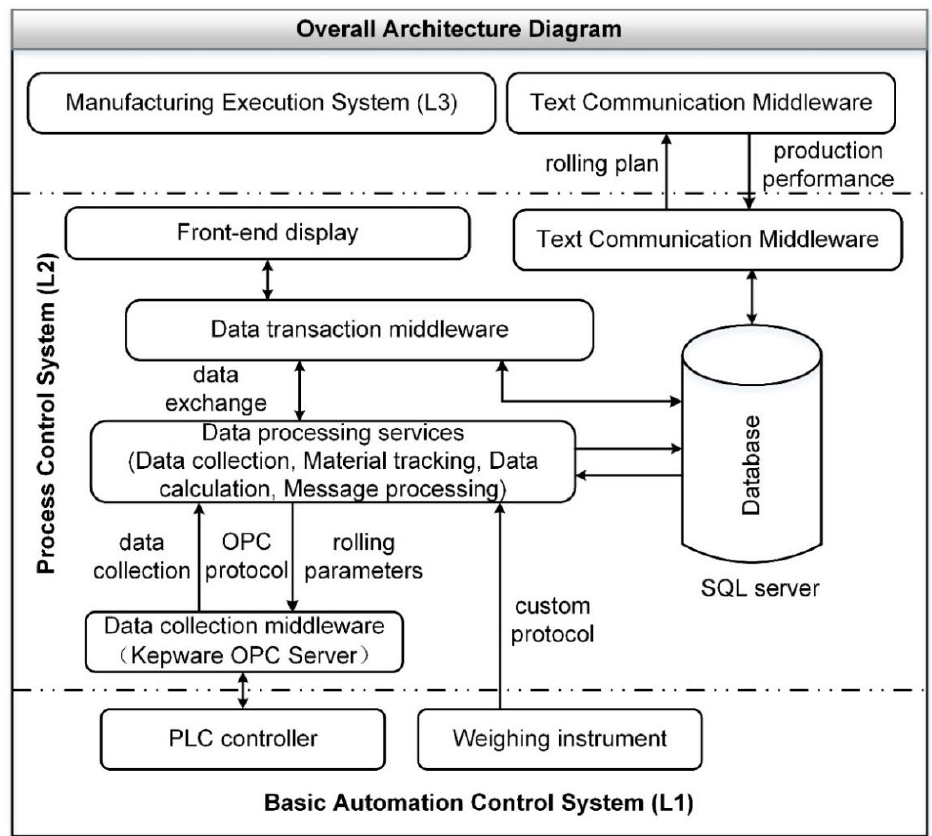
Figure 12. Overall architecture of the process control system [105].